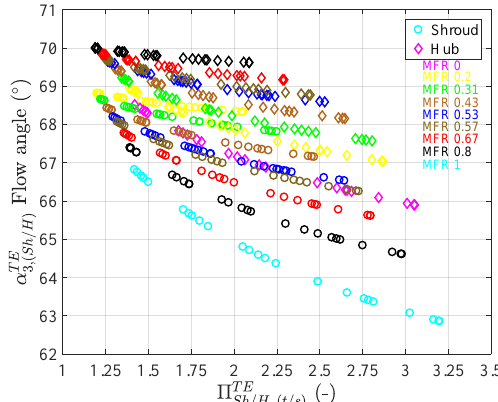
Figure 15. Rotor inlet flow angles at different flow admission conditions for Shroud and Hub branch of